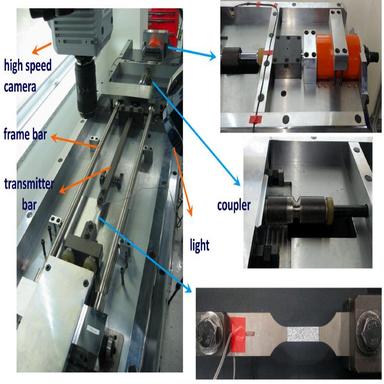
The experimental set-up for sheet metal IFHS tests.